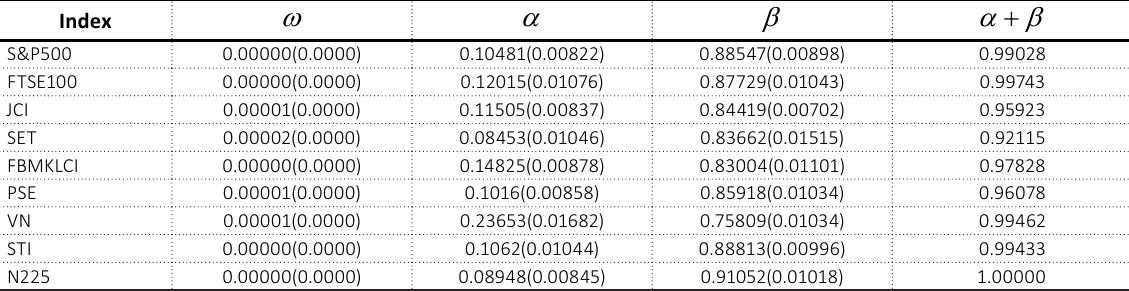
Table 5. Univariate generalized autoregressive conditional heteroskedasticity (GARCH (1,1)) estimates